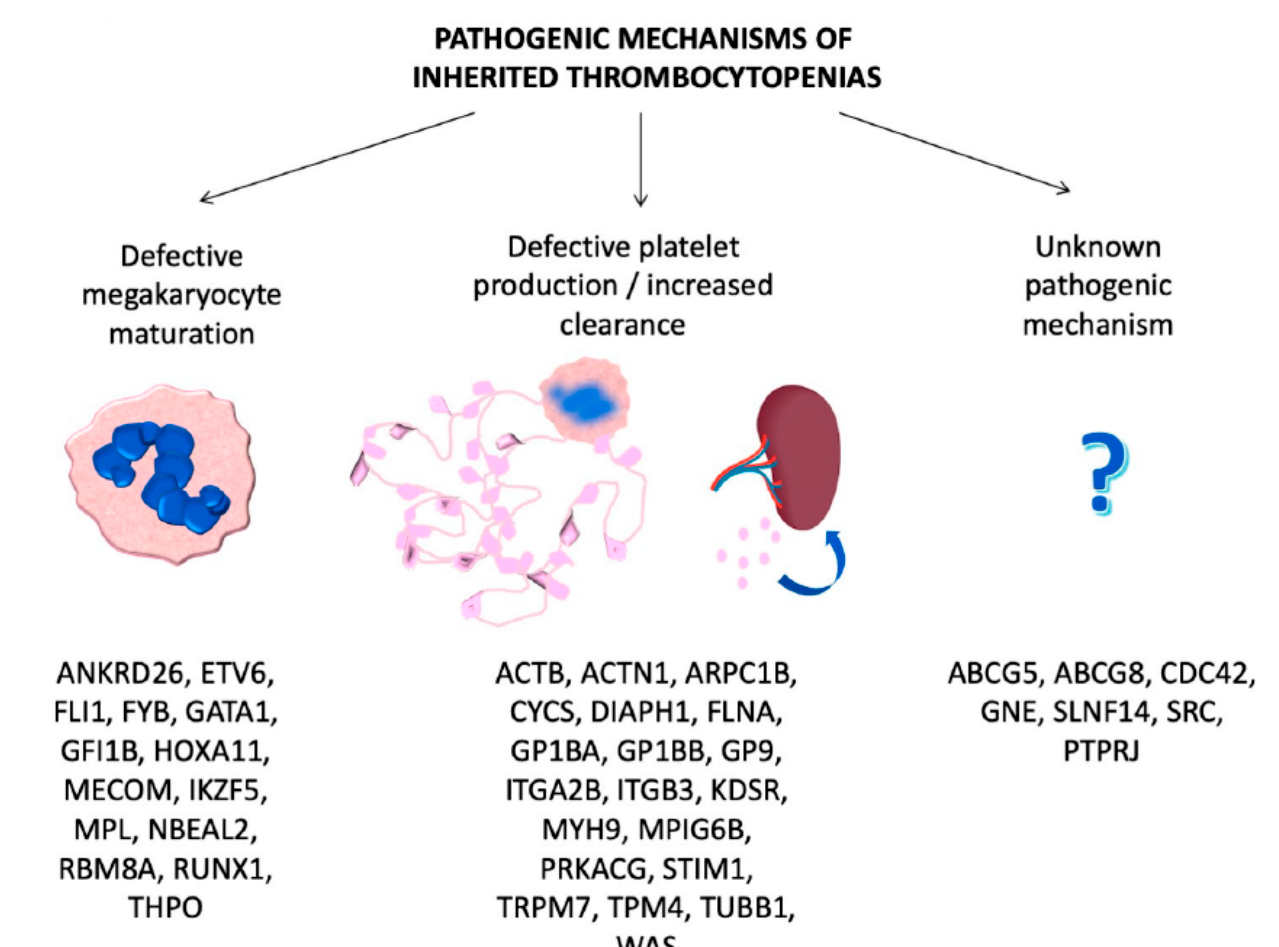
Figure 1. Genes involved in inherited thrombocytopenias classified according to the pathogenic mechanisms.